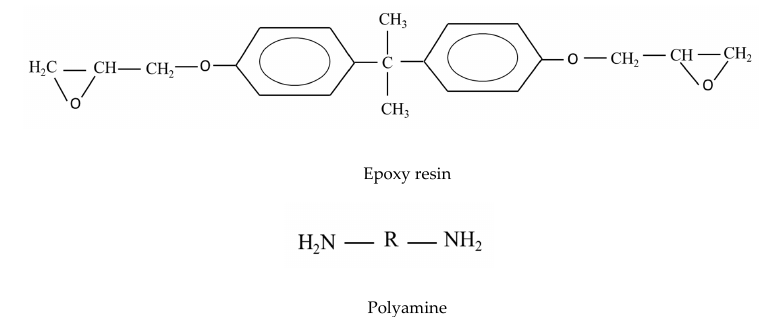
Figure 1. Chemical structure of epoxy resin (Epotec YD-535 LV) and hardener (Epotec TH-7257).